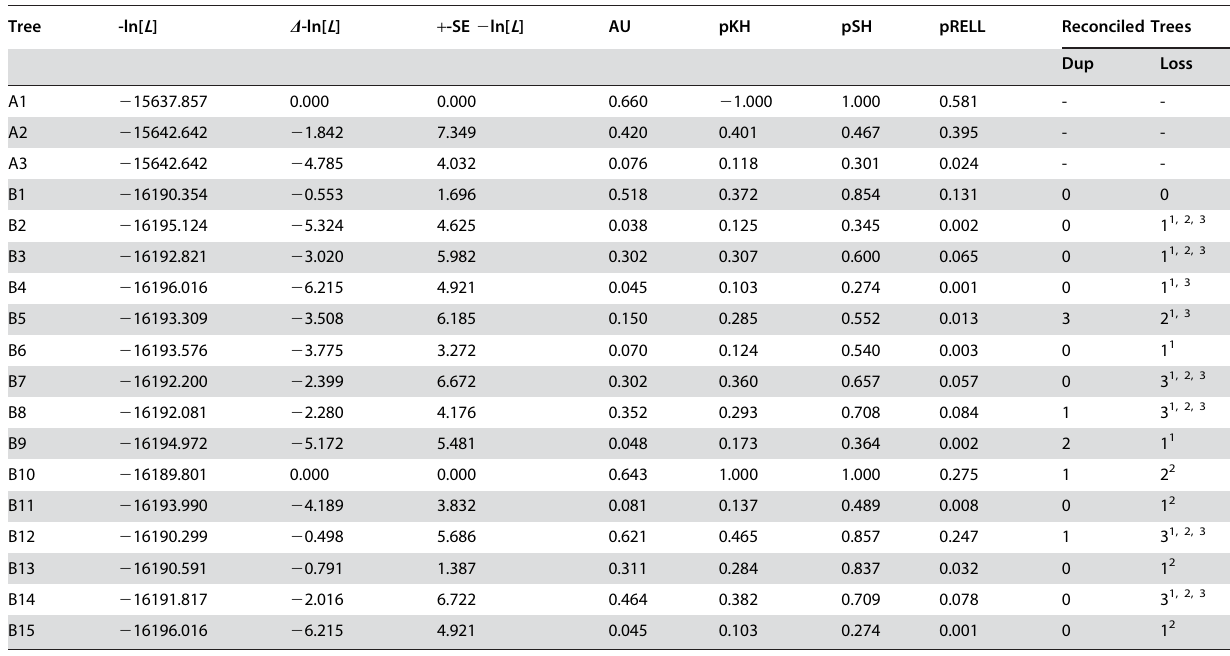
Table 1. Likelihood comparisons for alternative hypotheses of opsin evolution .. ... .... ... ... .... ... ... .... ... ... .... ... ... .... ... ... .... ... ... .... ... ... .... ... ... .... ... ... .... ... ... .... ... ... .... ... ... .... ... ... .... ... ... . Tree